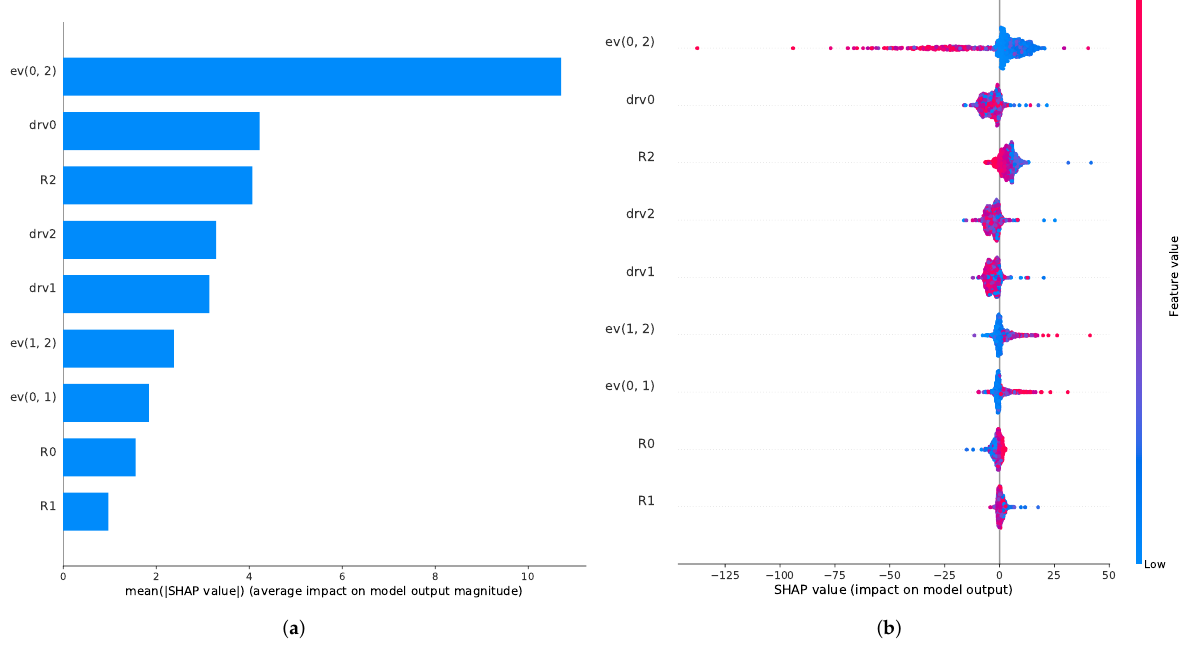
Figure 11. Feature importance plots for the LSTM model used in the drift study. ( a ) shows the mean SHAP values for the different features and ( b ) shows an overview of the different SHAP value